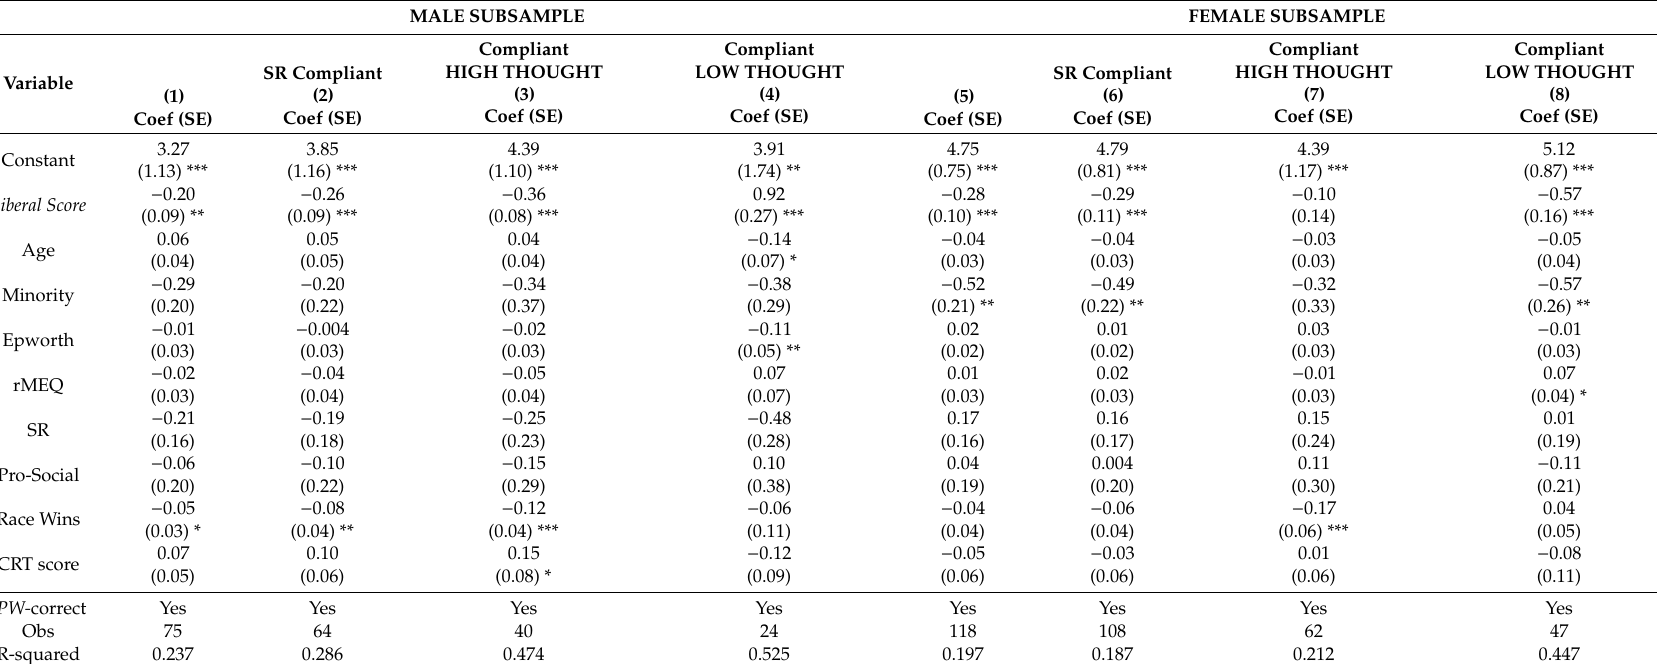
Table 4. Impact of Liberal Score on # PRO-GUN-RIGHTS CLIPS viewed—males vs